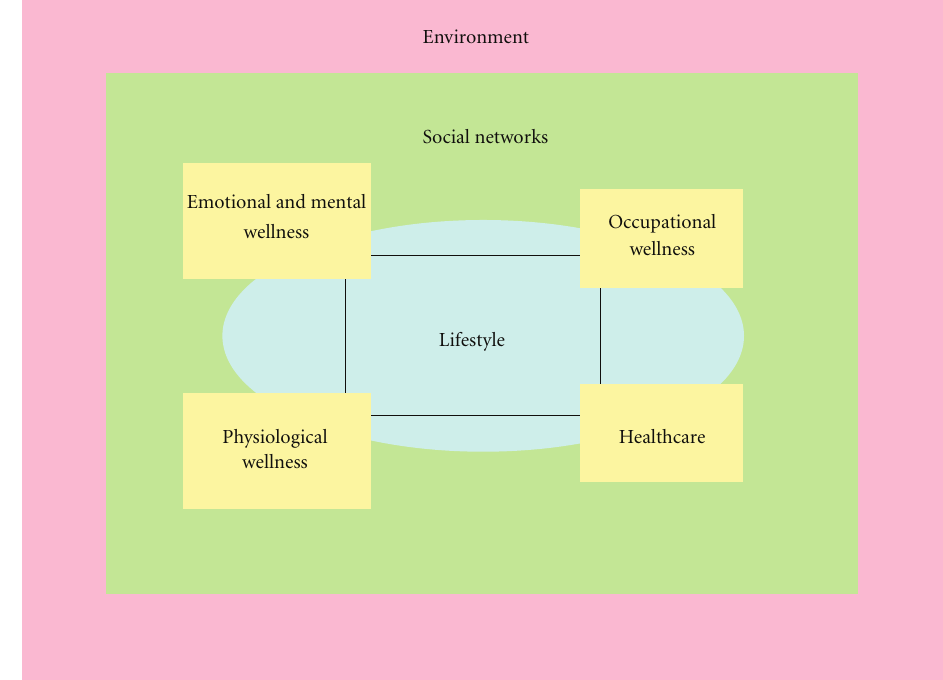
Figure 1: Personal wellness